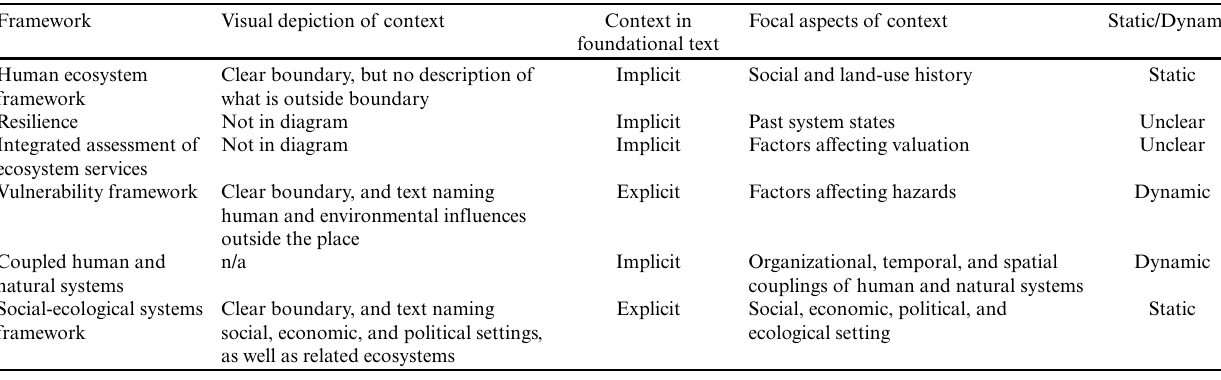
Table 5 . Comparing context in selected socio-environmental (SE)